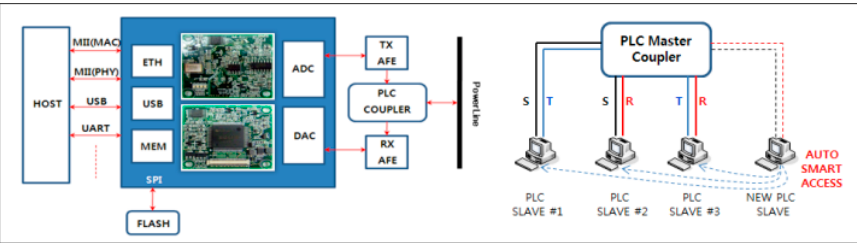
Figure 13. Algorithm of the PLC master coupler PCB.